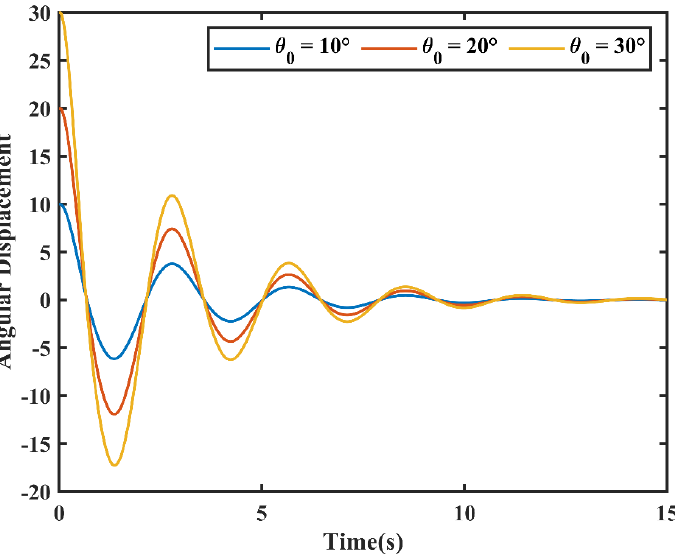
Figure 10. S-PWEC free decay test.